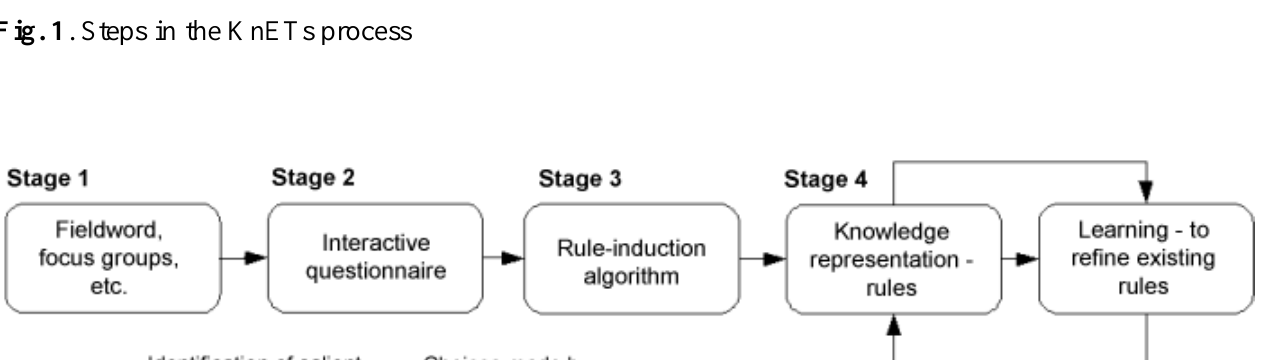
Fig. 1 . Steps in the KnETs